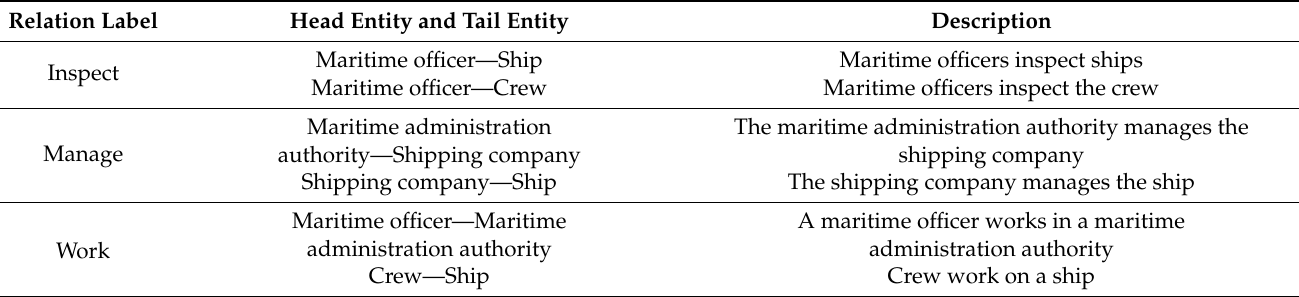
Table 2. Relations in the constructed knowledge